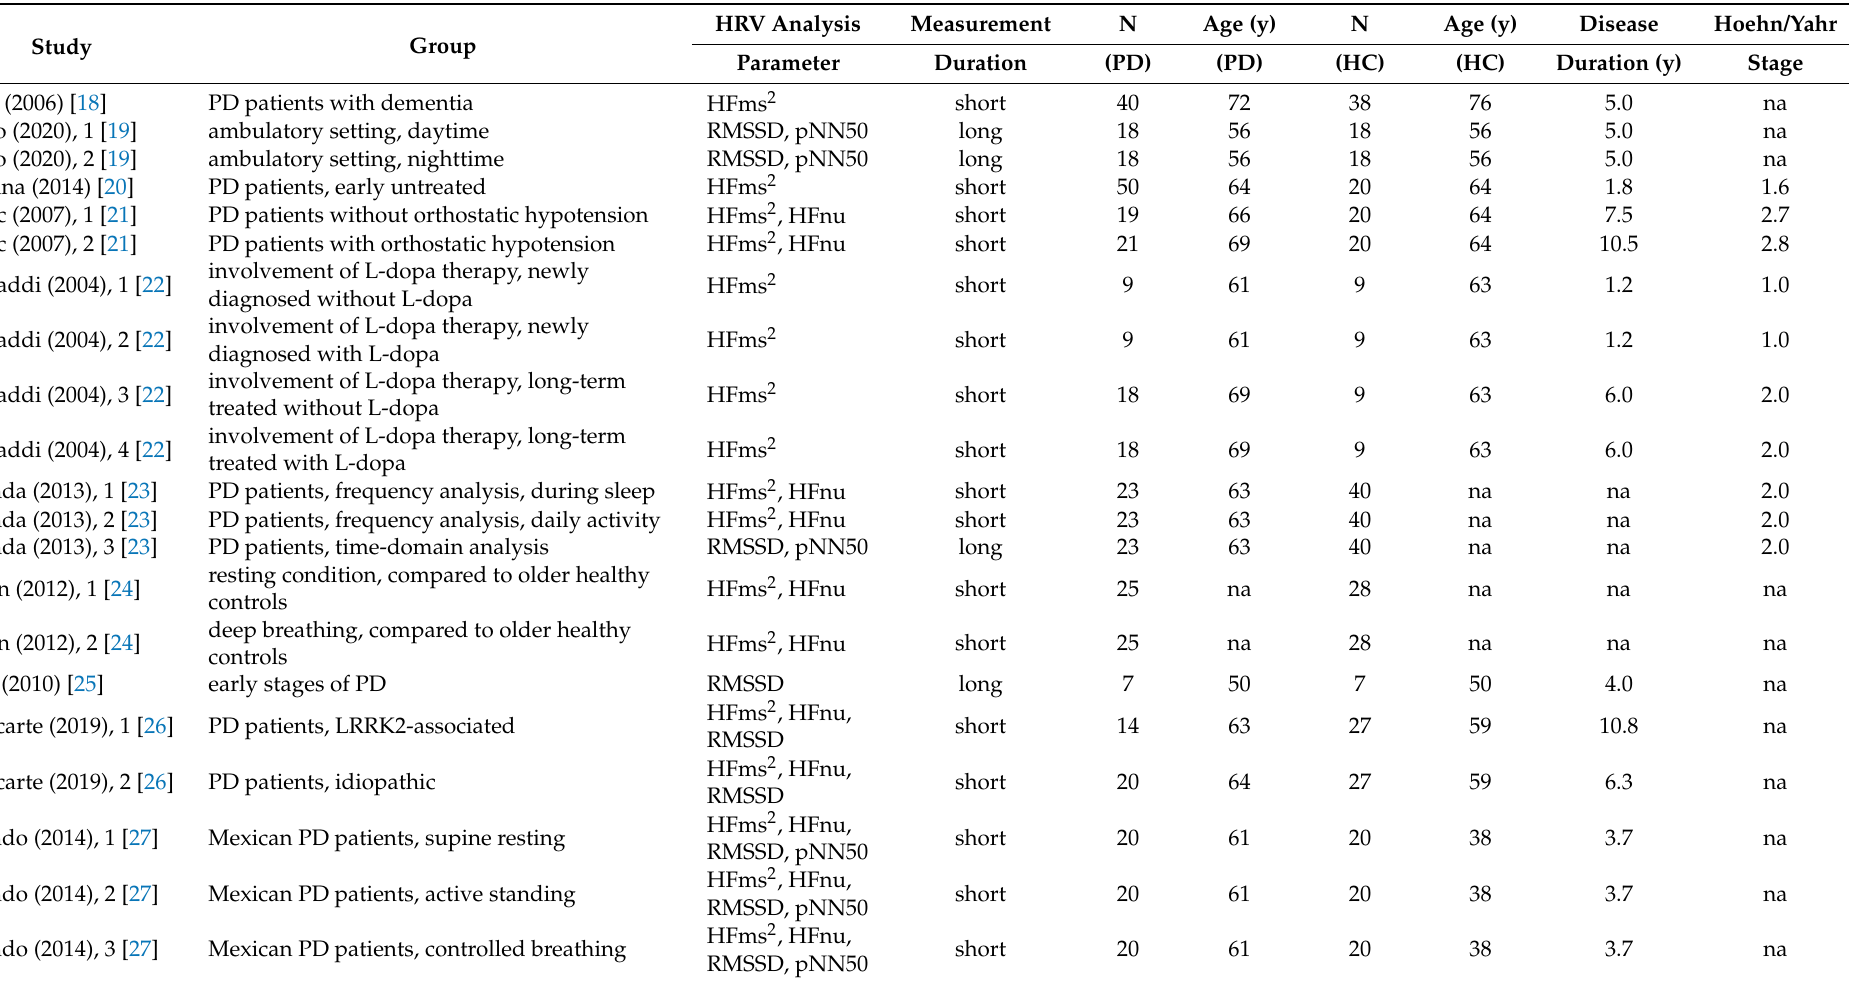
Table A1. Study selection,